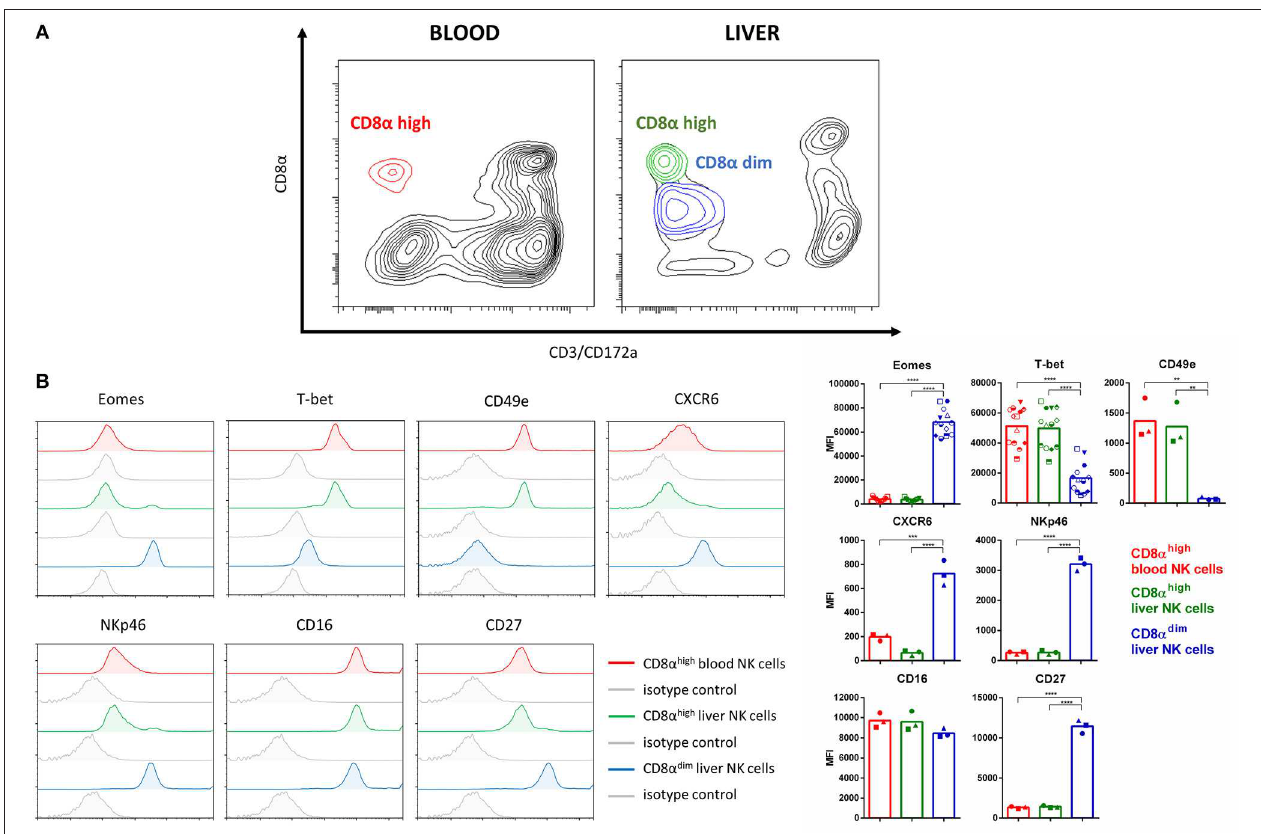
FIGURE 1 | Identification of a porcine liver NK cell subpopulation that shows remarkable similarity to human lrNK cells. (A) Flow cytometric contour plots showing conventional NK cell populations in blood and liver and the additional liver NK population that shows lower CD8 α expression. Plots show cell populations before MACS depletion and FACS sorting. A bi-exponential scale was used for the x and y-axis. (B) Flow cytometric histograms show the expression of Eomes, T-bet, CD49e, CXCR6, NKp46, CD16, and CD27 on conventional CD8 α high blood NK cells (red), conventional CD8 α high liver NK cells (green), and the additional CD8 α dim liver NK cell population (blue). Specific signals and isotype controls (gray) are shown for each marker. Graphs show the median fluorescence intensity (MFI) values for each of the markers. Bars represent the mean value, different symbols correspond to individual data points from different animals. For all markers except Eomes and T-bet, data for three different animals are shown. Since Eomes and T-bet expression was also assessed for other assays in this study as a control to check for correct phenotype of the different NK populations, individual data points for more animals ( n = 13) are available and shown for these two markers. A logarithmic scale was used for the x-axis. Statistically significant differences are indicated with asterisks (** p < 0.01, *** p < 0.001, **** p < 0.0001).